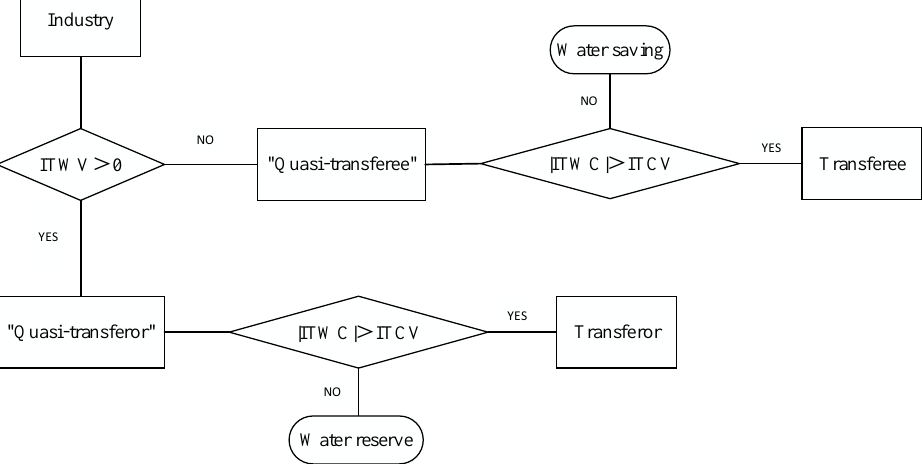
Figure 2. The schematic diagram of preliminary judgment of water-rights transaction subjects. (ITWV is short for tradable water volumes of industry. ITCV is short for tradable control volumes of industry.)